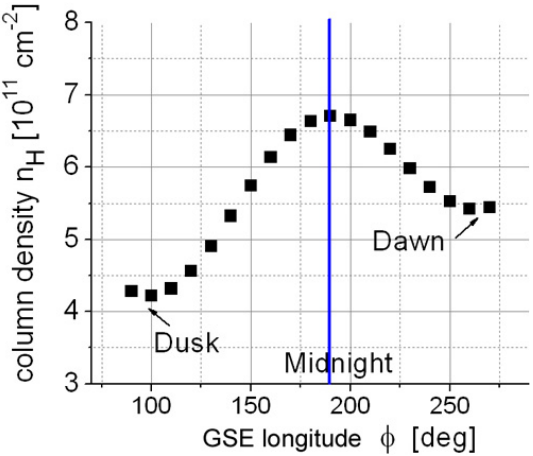
Fig. 11. Dawn/dusk asymmetry of the H-column densities (between 3–10 R E ) for longitudinal angles φ = 90–270 ◦ taken from the sea- sonal averaged model fit.